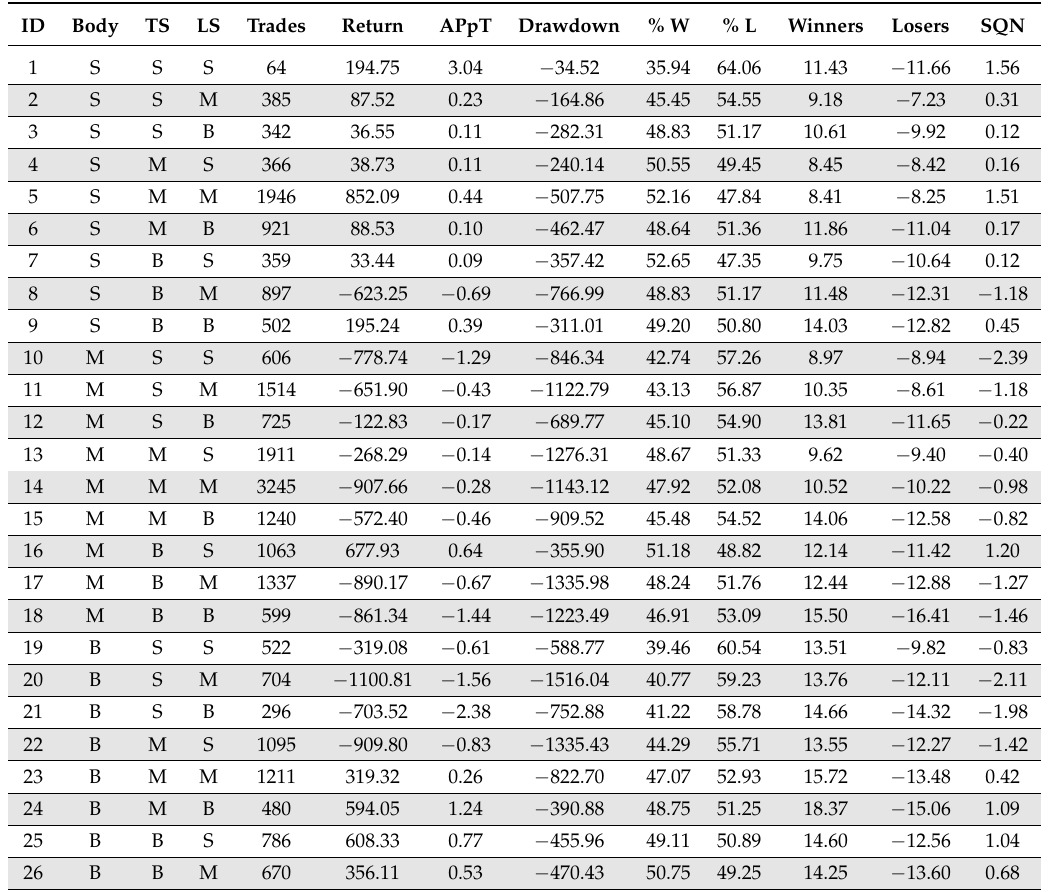
Table 3. Results from a long-only strategy. Candlesticks IDs 1–27 are bullish, while Candlesticks IDs 28–54 are bearish. It is highlighted the best SQN-performing strategy, which corresponds to an entry condition defined by candlestick ID